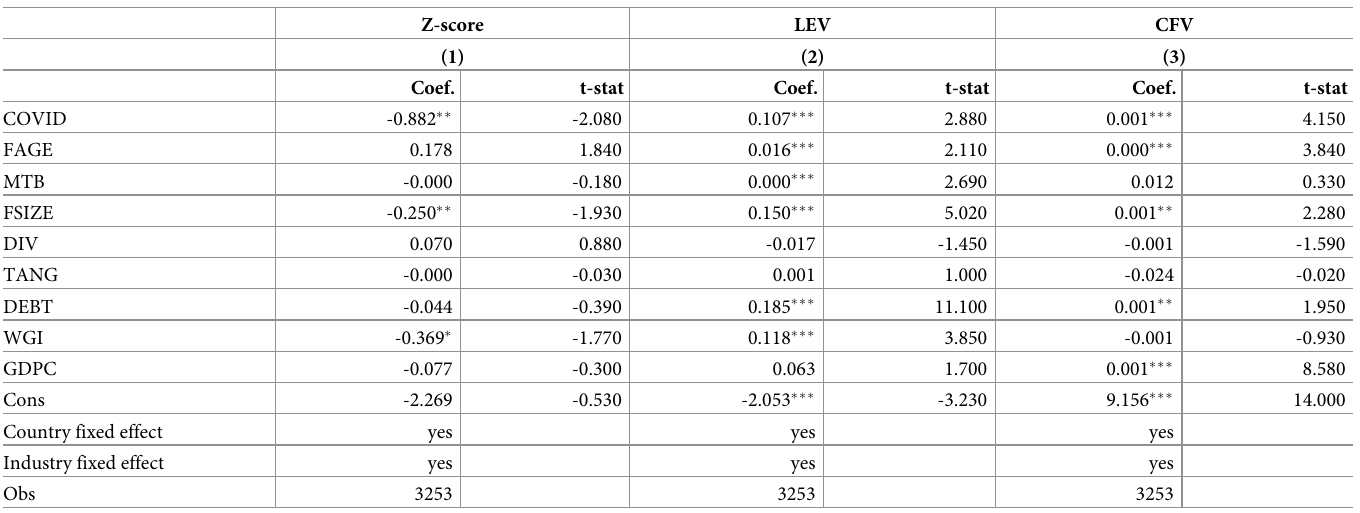
Table 5. COVID-19 and firm risk results.